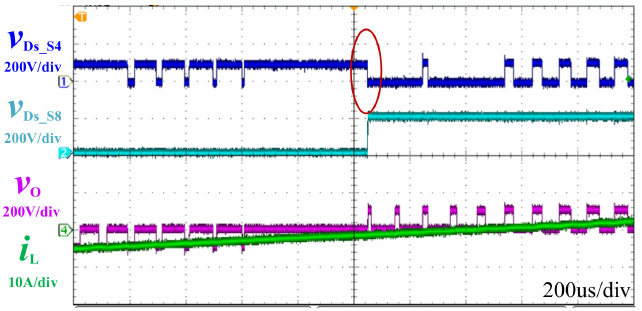
Figure 11. Reliable switching process of proposed modified modulation